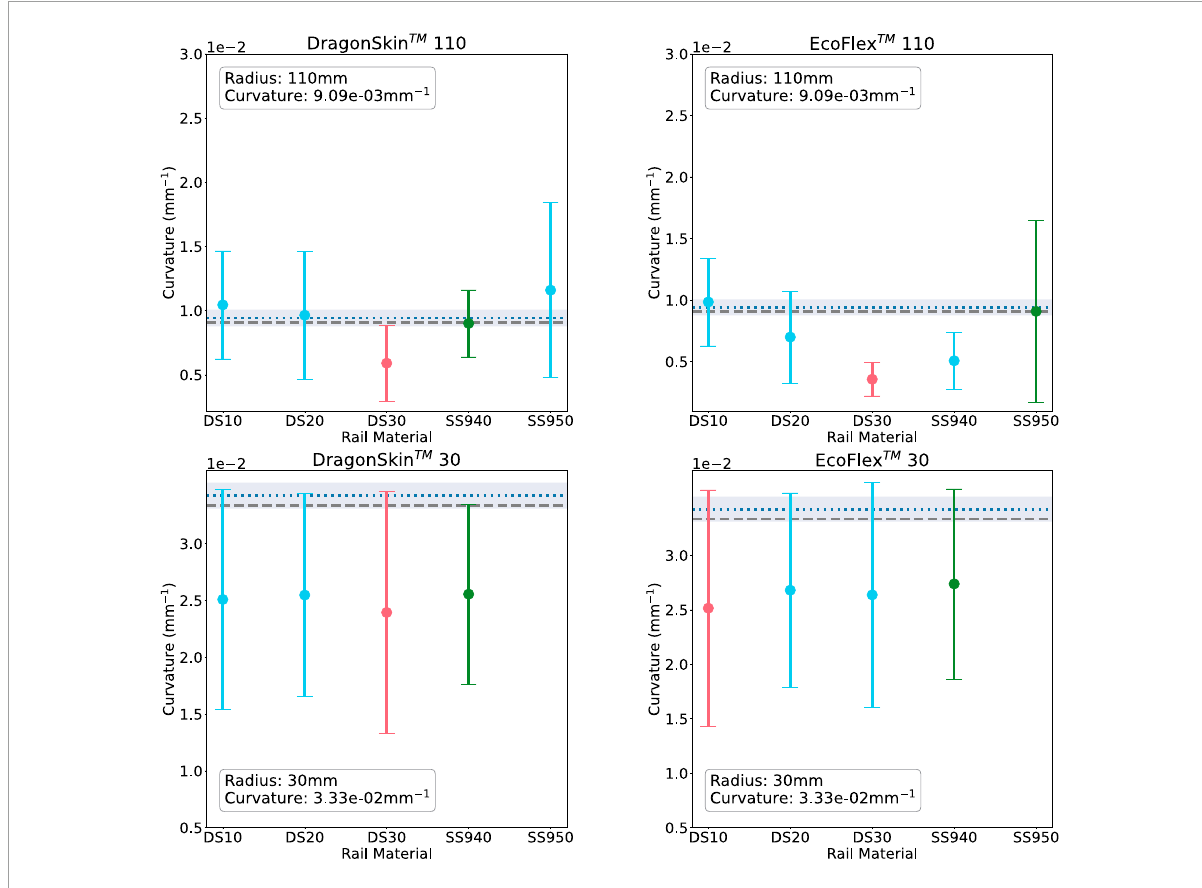
FIGURE 9 Rail-sensed curvature at 110 mm (top) and 30 mm (bottom) on the soft phantoms: DragonSkin™(L) and EcoFLex™(R). The materials on the x -axis are in order of increasing material stiffness. Green corresponds to the rail with best sensing accuracy, red to the